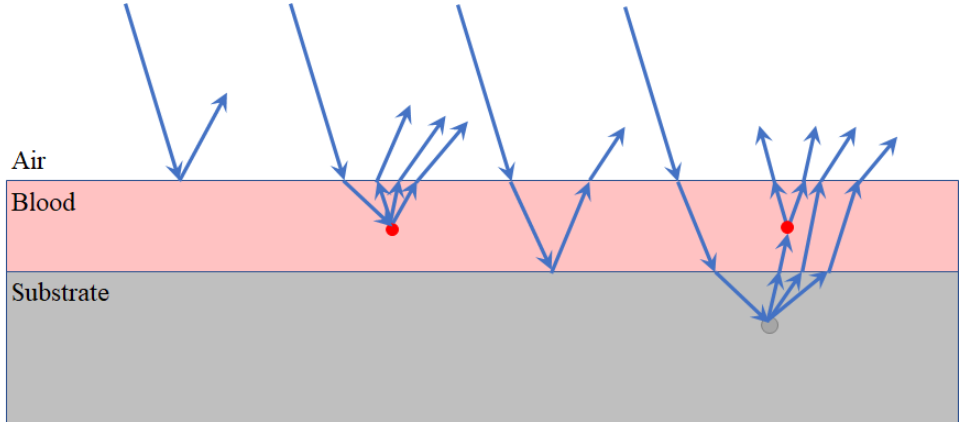
Figure 1. Scheme of the light scattering paths on blood stain over a